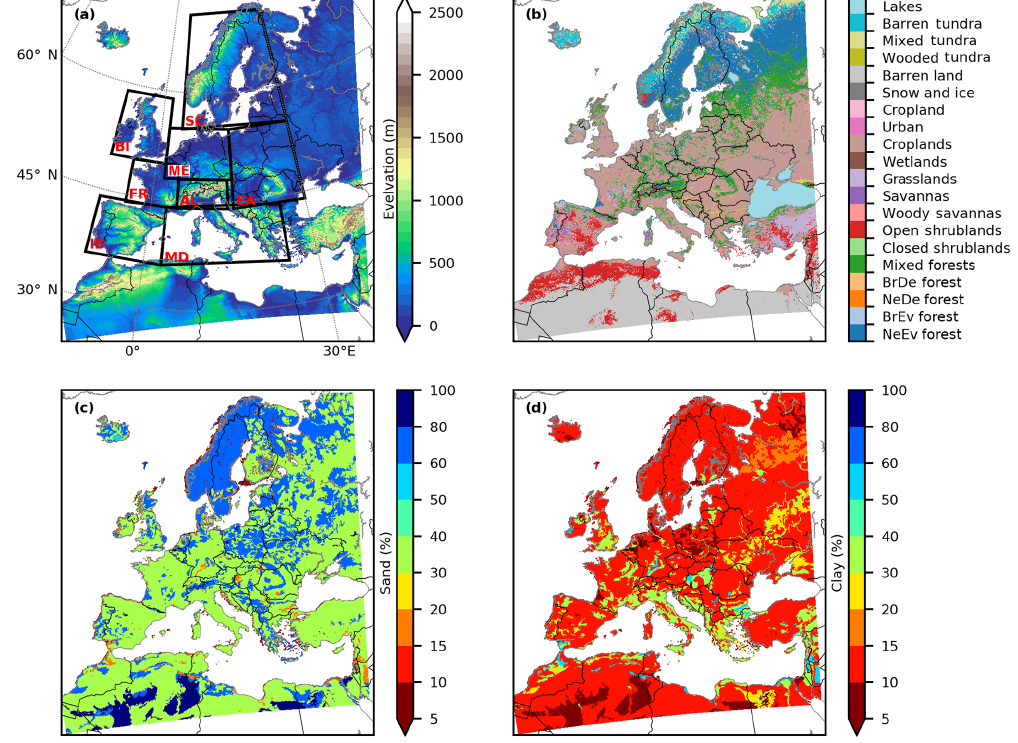
Figure 1. Model surface input data: (a) USGS GMTED2010 DEM, (b) dominant land use type based on MODIS data, (c) percentage of sand content, and (d) percentage of clay content based on global FAO soil database. The inner boxes in (a) show the boundaries of the PRUDENCE regions (FR: France, ME: Mid-Europe, SC: Scandinavia, EA: eastern Europe, MD: Mediterranean, IP: Iberian Peninsula, BI: the British Isles, AL: Alpine region; Christensen and Christensen,